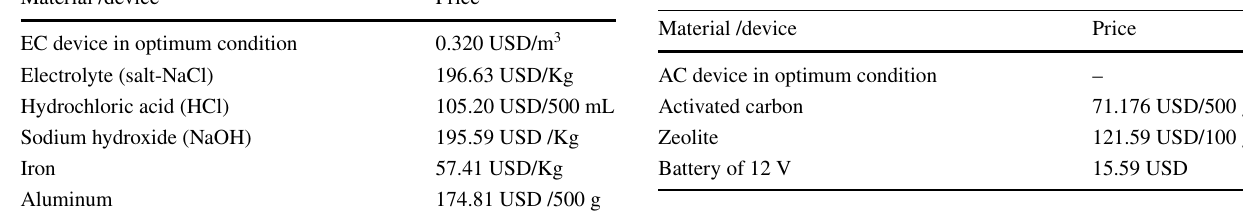
Table 12 Economic evaluation of AC